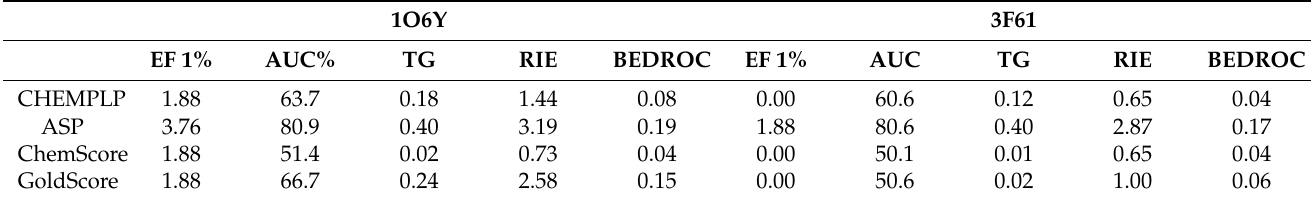
Table 3. Evaluation metrics for Active vs. Decoys virtual screening results for the selected targets.